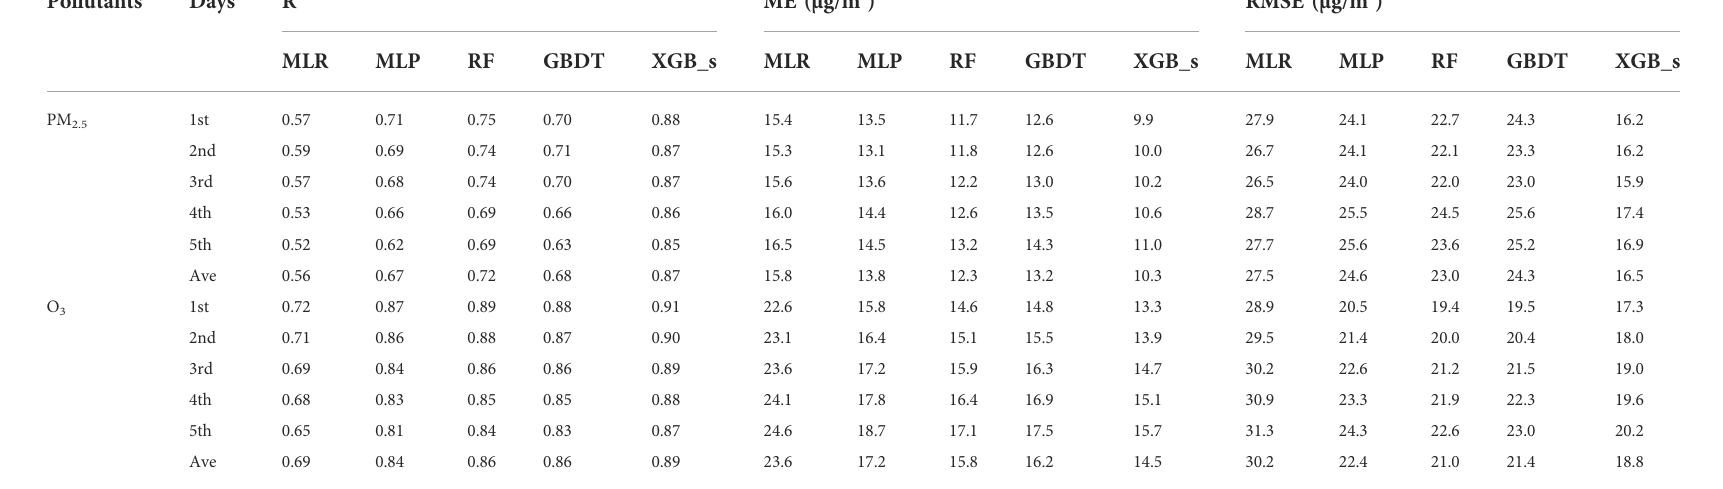
TABLE 3 Statistics of evaluation criteria between XGBoost-SMOTE model and other machine learning models.